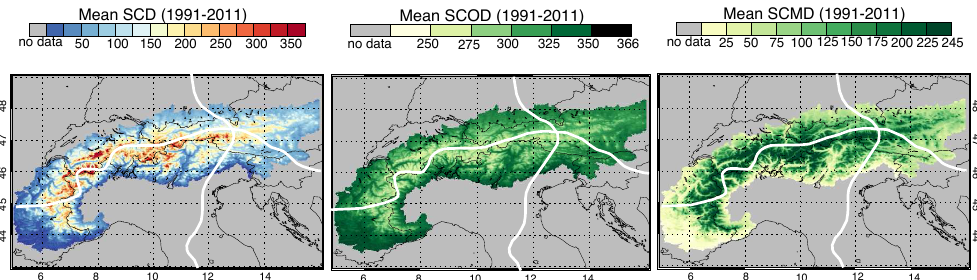
Fig. 5. Spatial representation of the long-term annual mean of snow cover parameters for the Alpine region (1991–2011): SCD (left) in numbers of snow days, SCOD (center) and SCMD (right), given as DOY for each pixel. Overall, a very strong correlation to the topography is observed but regional differences also become apparent. White lines indicate the climatic regions described in Sect. 2.